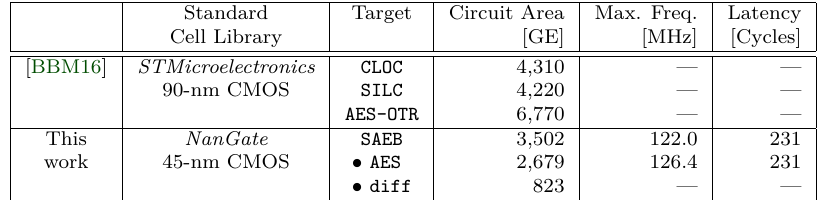
Table 5: Performance of SAEB in ASIC.